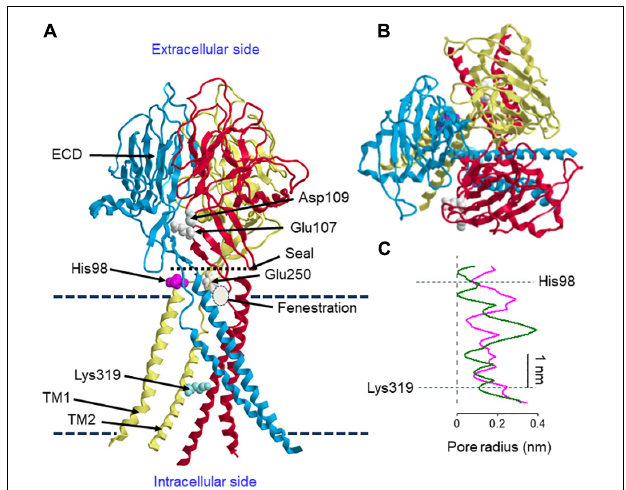
FIGURE 1 | Structural features of human ASOR/PAC. (A) Side view of the structure of ASOR/PAC formed by trimeric TMEM206 at pH 8. Proton sensor amino acid, His98, and the selectivity filter determinant, Lys319, are shown in one of the subunits. Upon protonation, His98 is expected to move to the acidic pocket formed by Glu250 of the cognate subunit and Glu107 and Asp109 of the adjacent subunit. Upper and lower broken lines indicate extracellular and intracellular membrane-liquid boundaries, respectively. Positions of the seal, fenestration and membrane boundaries are approximate. (B) Its top view. (C) Pore radius at pH 8 (green) and pH 4 (magenta). The structure is drawn according to Ruan et al. (2020) using